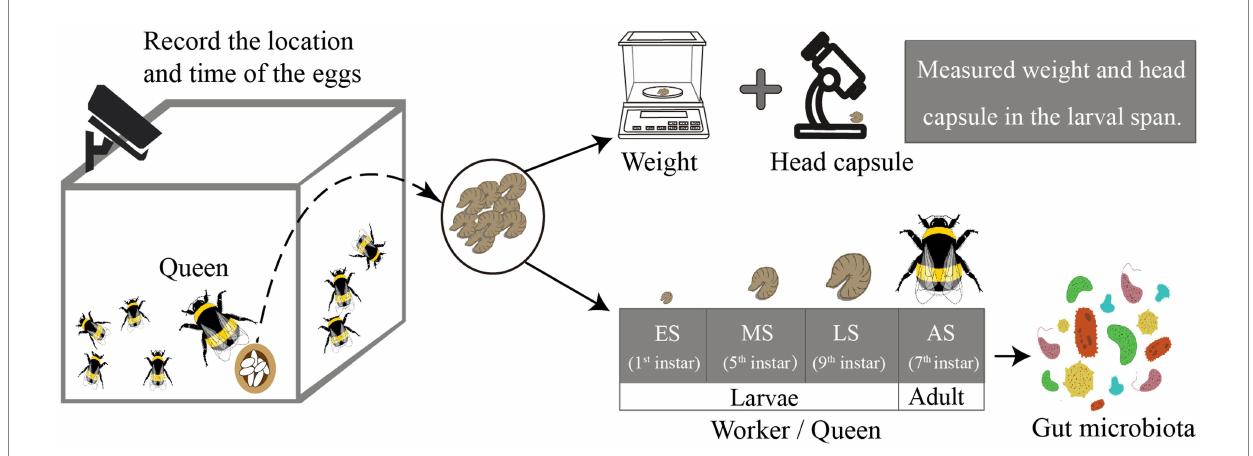
FIGURE 1 Schematic overview of this study. We monitored the development of larval in Bombus terrestris . Some larvae were used to measure morphological indicators while others were used to determine microbiota. The gut microbiota was sampled at four stages (ES represents early larvae stage, MS represents mid larvae stage, LS represents late larvae stage, and AS represents adult